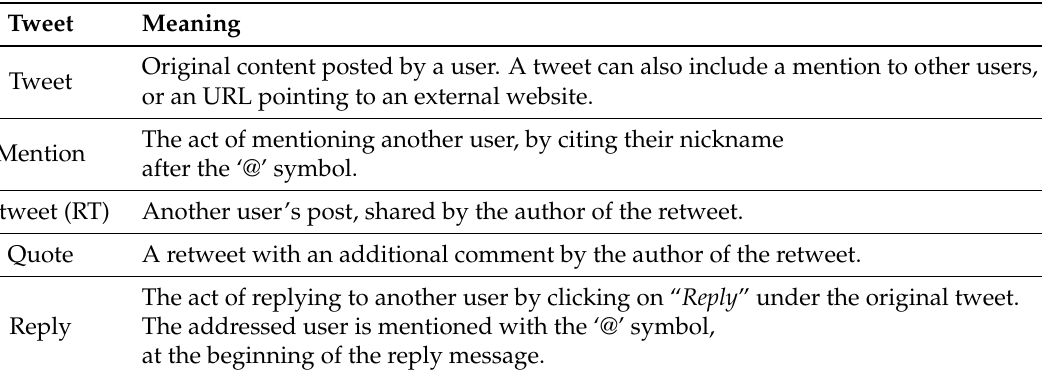
Table 1. Terminology used throughout the paper.